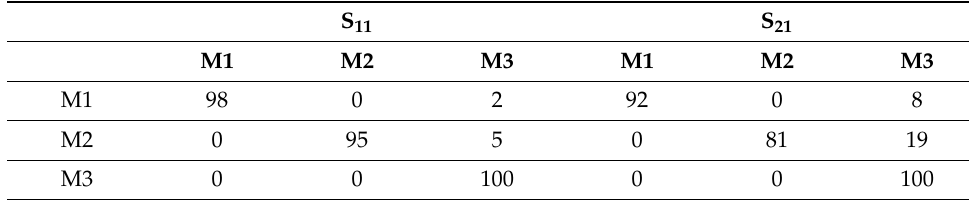
Table 5. Confusion matrix with detailed fault classification result using LR.